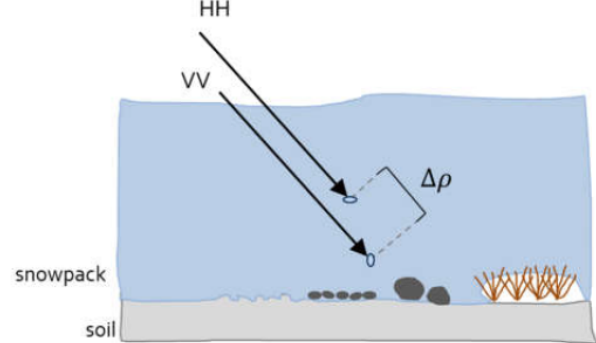
Figure 1. Phase shift ( (cid:49)ρ) can also be caused by scattering effects within the snowpack or by surface roughness (including vegetation) (credit: Anna